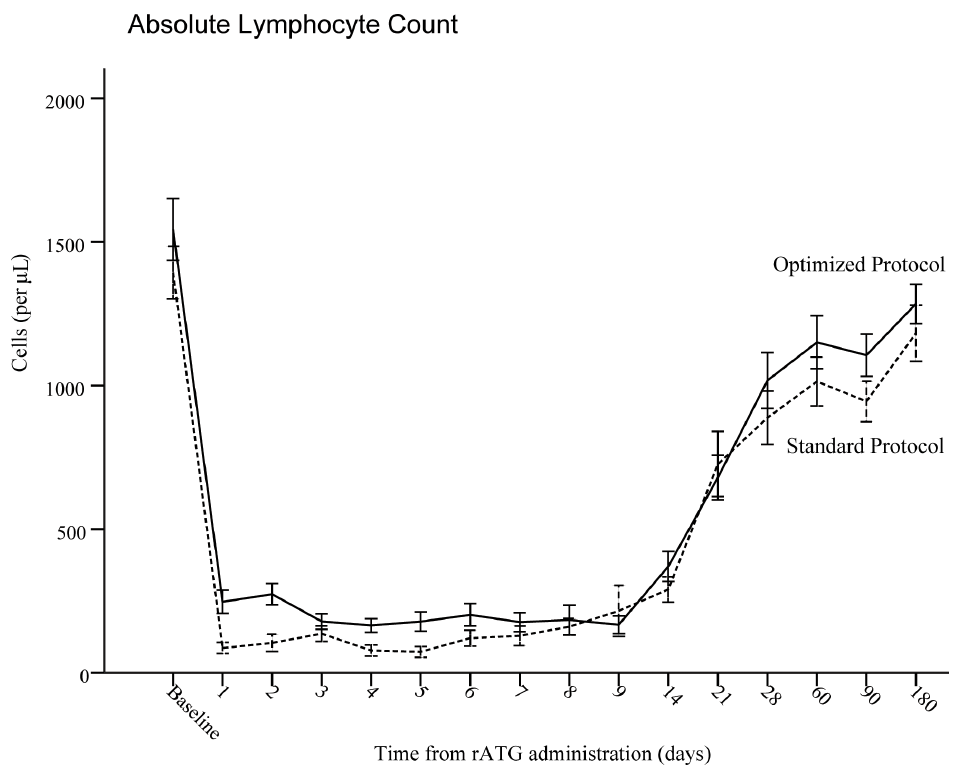
Figure 1. Absolute lymphocyte count (mean ± SE) following rATG administration. The degree and duration of lymphopenia were similar between Standard rATG (dotted line) and Optimized rATG (solid line) 9 days and 6 months following rATG administration.